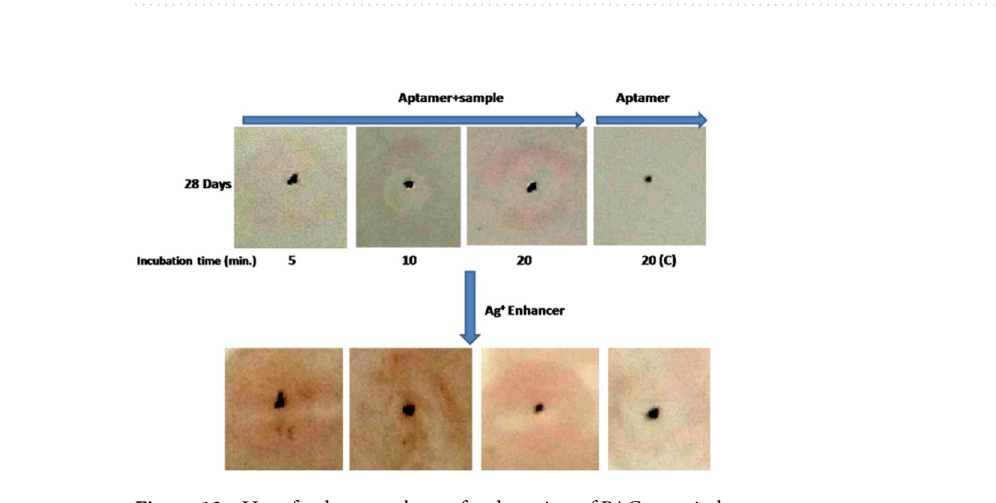
Figure 12. Use of nylon membrane for detection of PAG protein by aptamer.